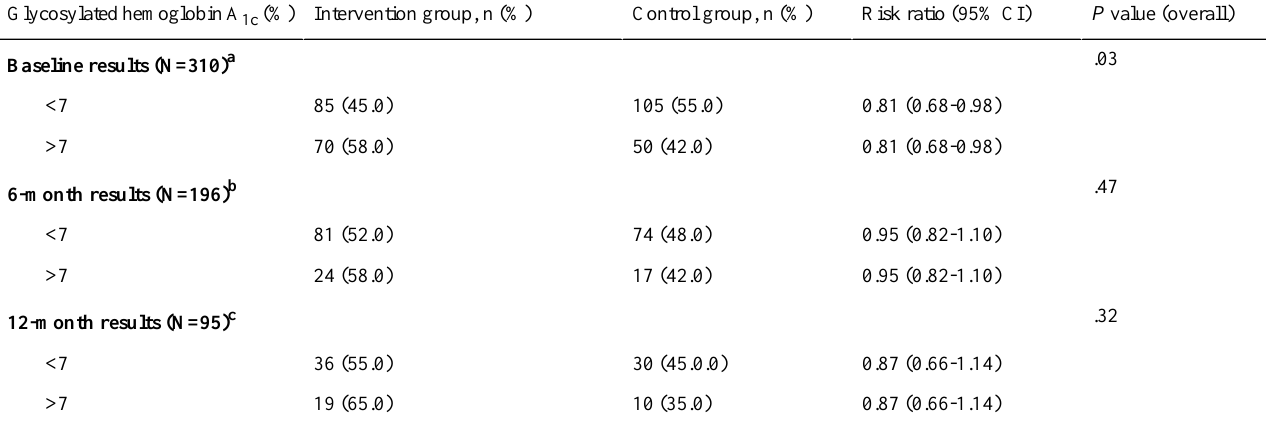
Table 4. Glycosylated hemoglobin A 1c